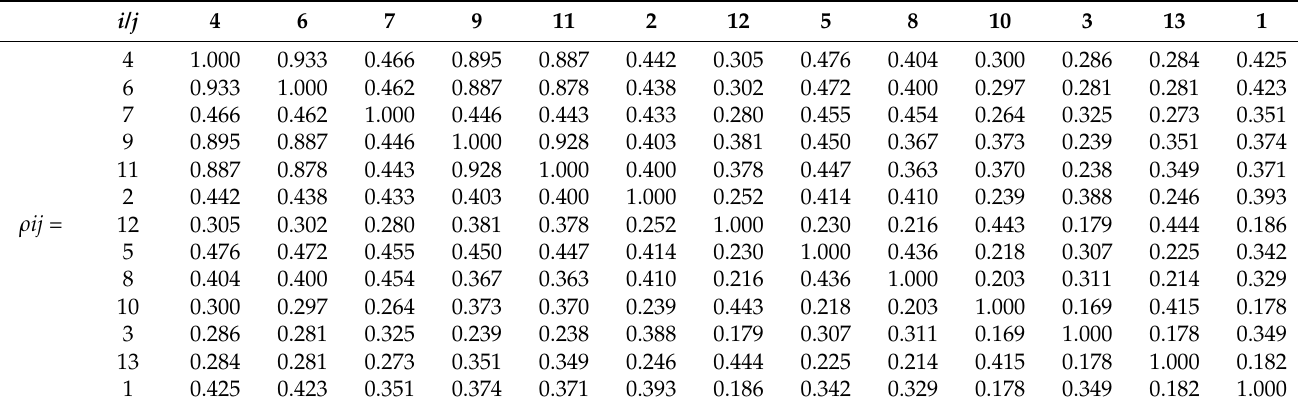
Table 3. The correlation coefficient matrix for the intact structure.